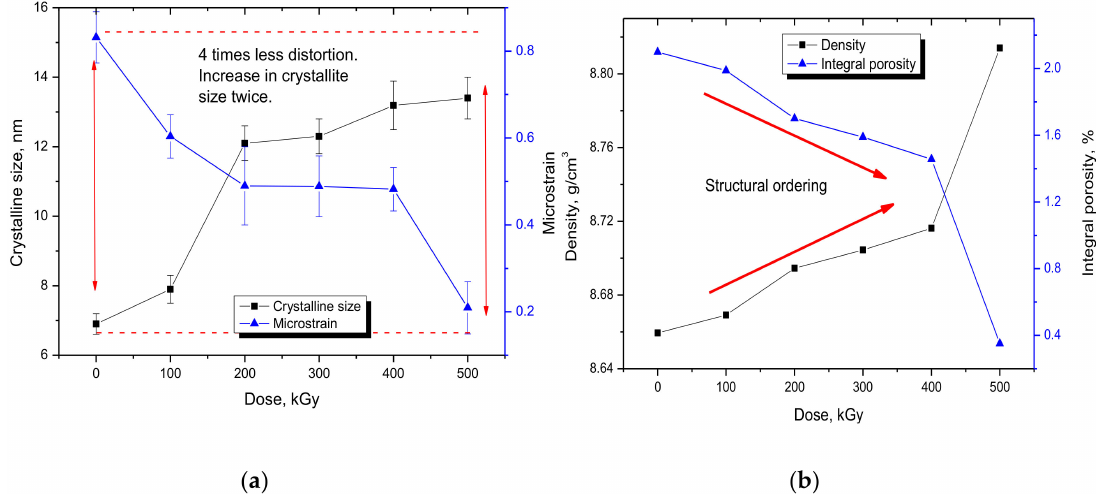
Figure 3. ( a ) The dynamics of changes in the size of crystallites and micro-distortions depending on the dose of radiation (the refinement of sizes and microstresses was carried out using the Williamson–Hall method); ( b ) graph of changes in the density and porosity of the studied nanostructures before and after irradiation.